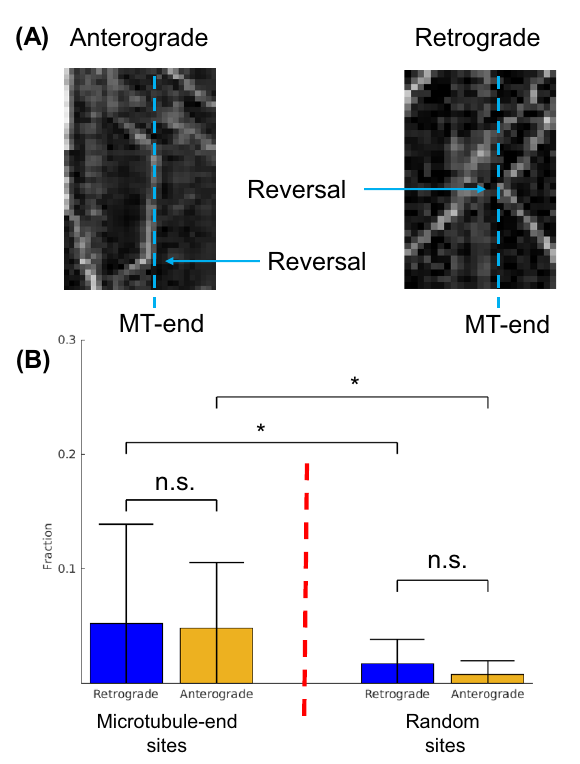
Figure 3. Vesicle reversal fraction after pausing at a microtubule-end. ( A ) Both anterograde and retrograde motion exhibit reversals at a microtubule-end location. Reversals are not observed to correlate with pause time. ( B ) The overall fraction of reversals at microtubule-ends is < 0.05 for both retrograde and anterograde motion. There is no statistical difference for direction of motion at MT-end. The overall fraction of reversals at random locations along the axon is < 0.02 for both retrograde and anterograde motion. There is no statistical difference for direction of motion at random locations. Error-bars are determined by standard-deviations in fraction of observed traversals per location. * = p < 0.05, two-tailed student